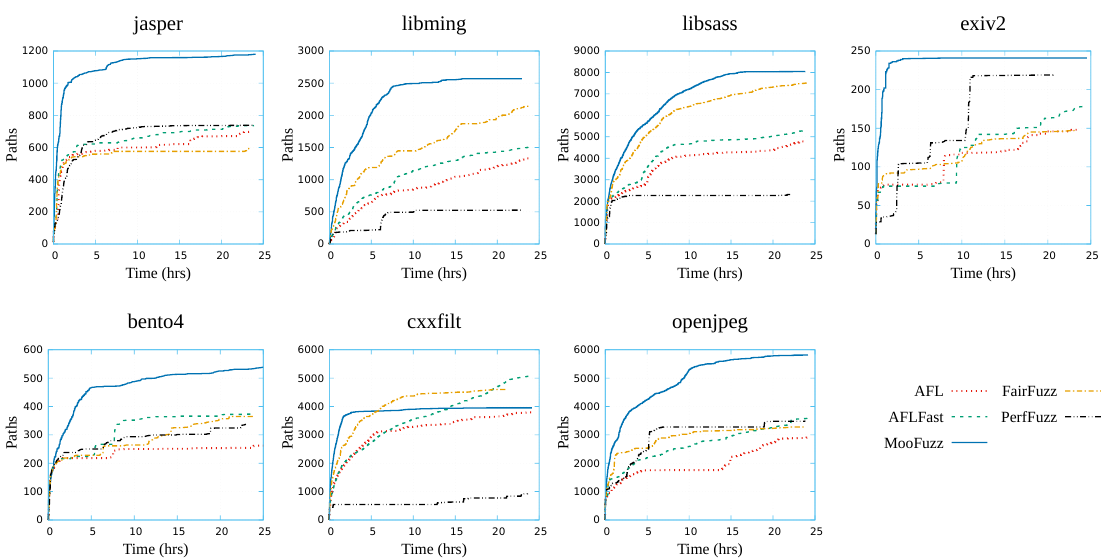
Figure 4. The growth trends of paths discovery in different fuzzers within 24 h. Overall, MooFuzz outperforms other fuzzers in terms of line, function, and path coverage.